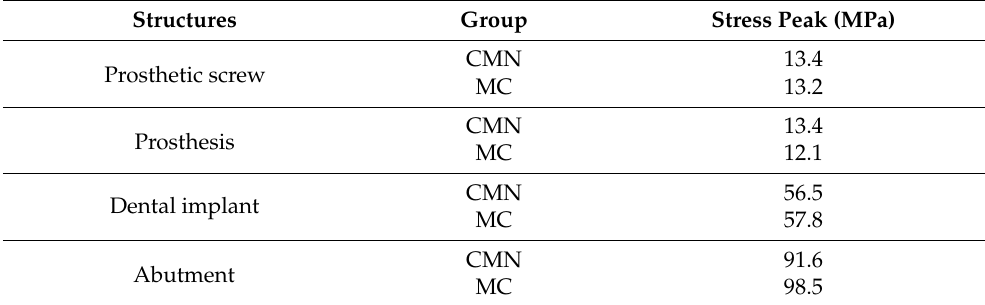
Table 3. Maximum principal stress peaks (MPa) in the structures of the MC and CMN